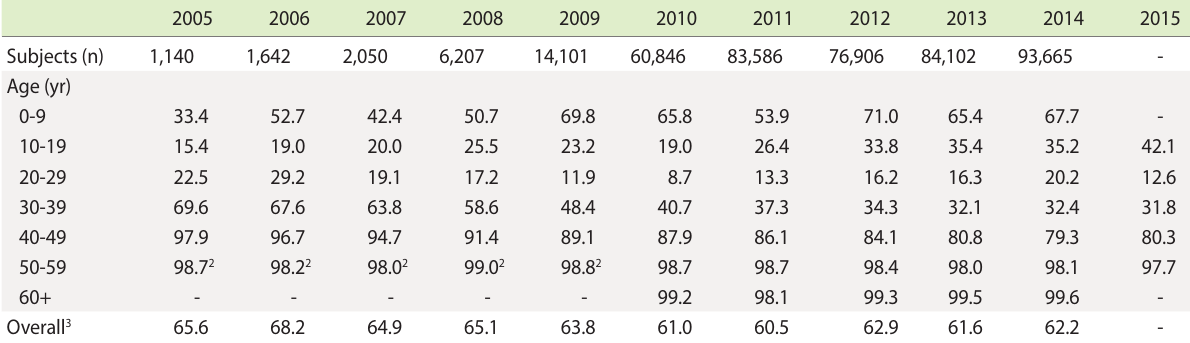
HAV, hepatitis A virus. 1 Seroprevalence of anti-HAV was adjusted by area from 2005 to 2009 and by area and sex from 2010 to 2014. 2 From 2005 to 2009, people over 50 years old presented in groups because of the small numbers and similar seroprevalence. 3 Overall seroprevalence was adjusted by age, area, and/or sex using the 2010 population. Data sources from: 2005-2014: Kim et al. PLoS One 2017;12:e0170432 [6]; 2015: Lim et al. PLoS One 2017;12:e0189210 [8].